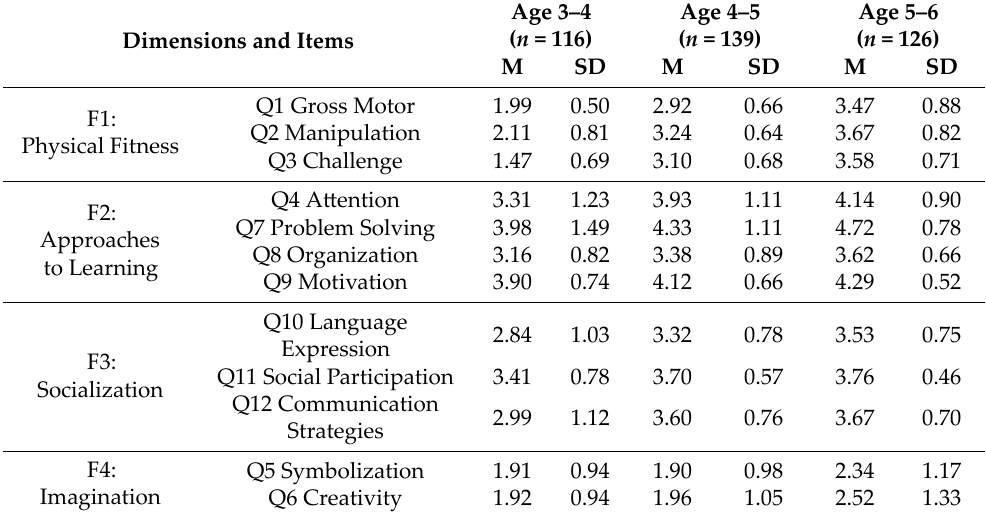
Table 1. Descriptive Statistics ( n =